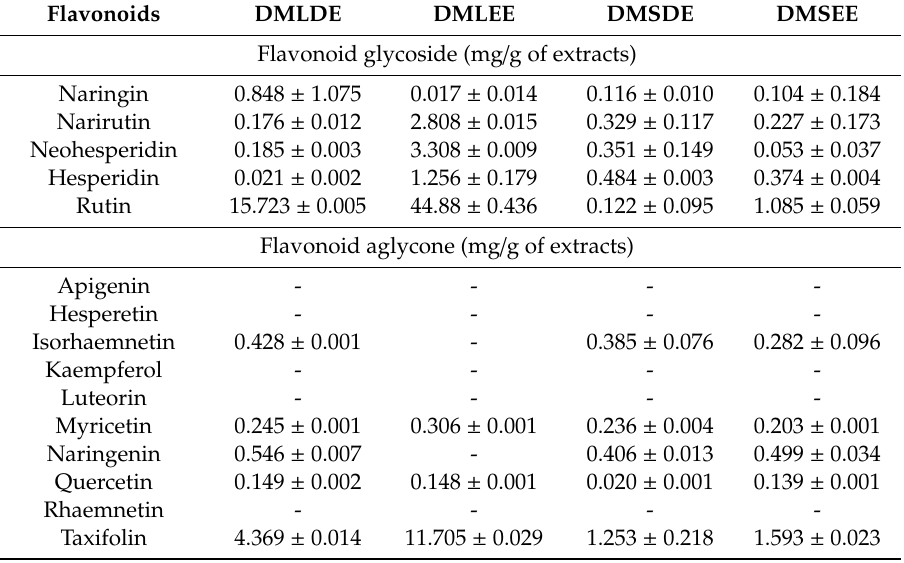
Table 1. Individual flavonoid contents in the Dendropanax morbifer leaf and stem extracts (unit: ug / g of